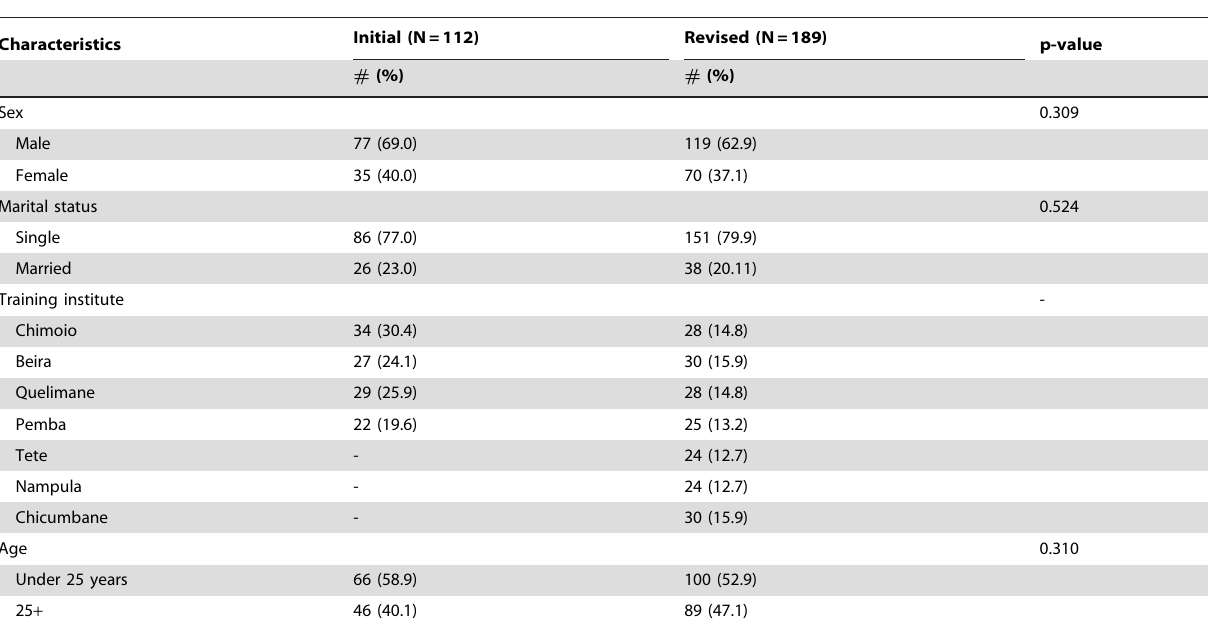
Table 2. Comparison of demographic characteristics of TMGs in Initial vs. Revised curriculum*.